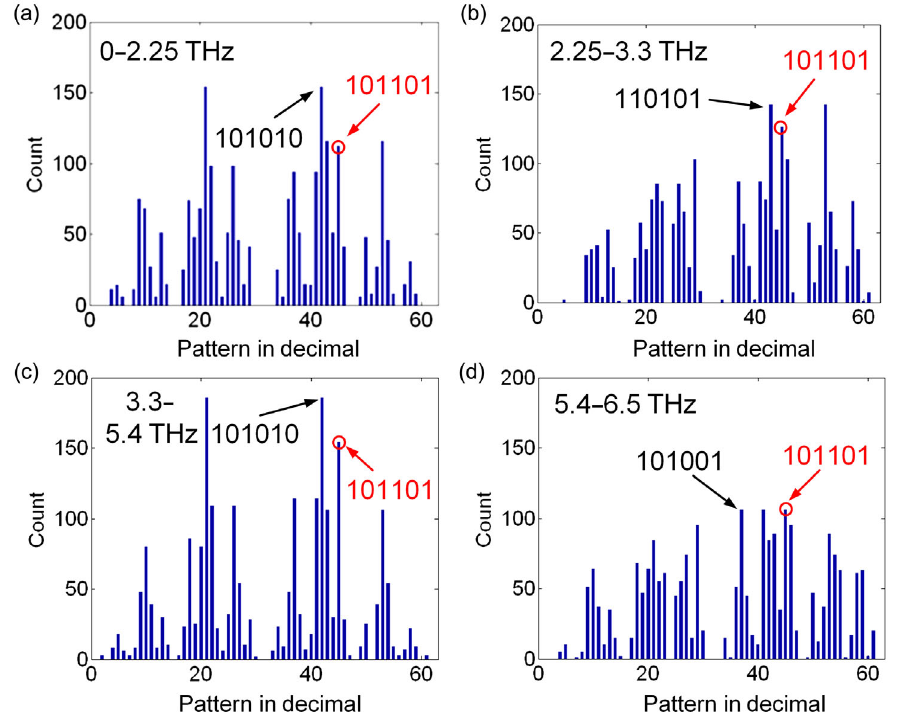
FIG. 5. Histograms of local 6-UL patterns of 100 structures that give small thermal conductivity in the specific four frequency ranges. Four key local structures are identified: 101010, 110101, 101001, and 101101, which are present in the optimized